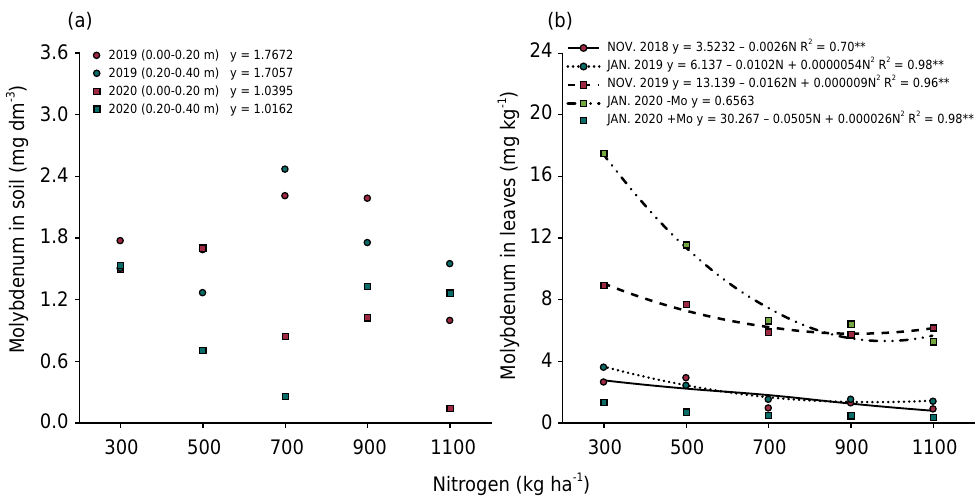
Figure 5. Contents of molybdenum at layers of 0.00-0.20 and 0.20-0.40 m in the soil (a) and leaves of Conilon coffee (b), for the harvests 2018/2019 and 2019/2020, in response to the application of molybdenum and nitrogen doses. ** significant at 1 % probability.